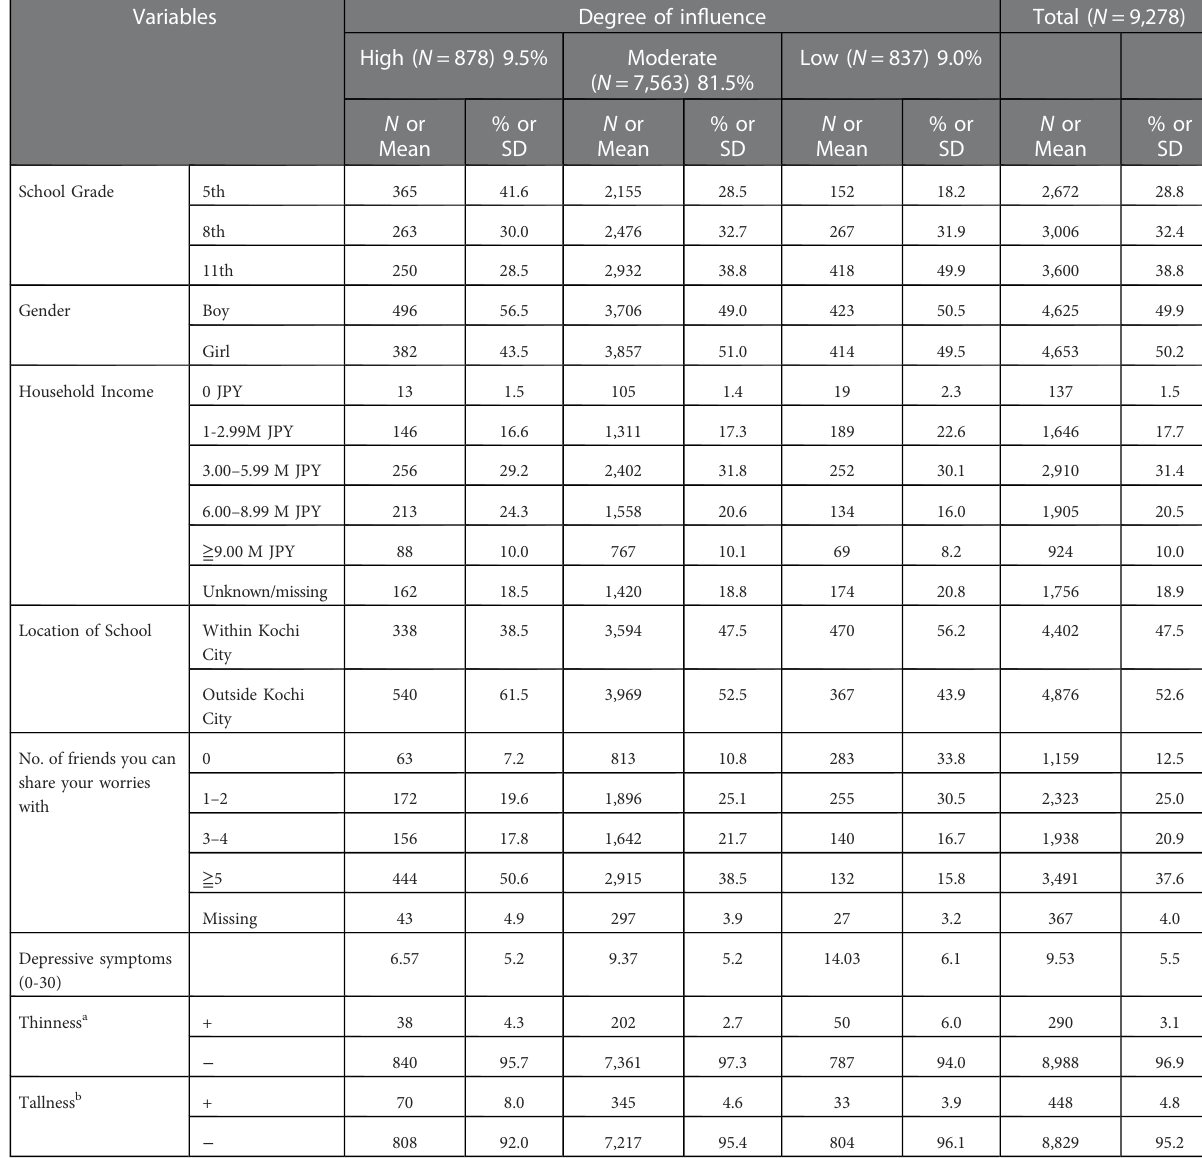
TABLE 1 Sample characteristics ( N =9,278).